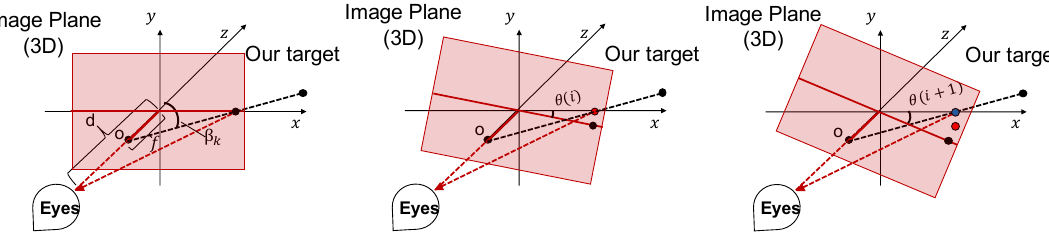
Figure 4. Geometry of roll motion in 3D. Images from the left to right illustrate when the camera rolls from angle 0 (aligned with the world coordinate) to angle θ ( i ) and to angle θ ( i + 1 ) and captures the object on the image plane. “Roll” means the camera rotates about the z axis at the camera’s center ( o ). β is the angular object position with respect to the world coordinate and is independent of the camera’s